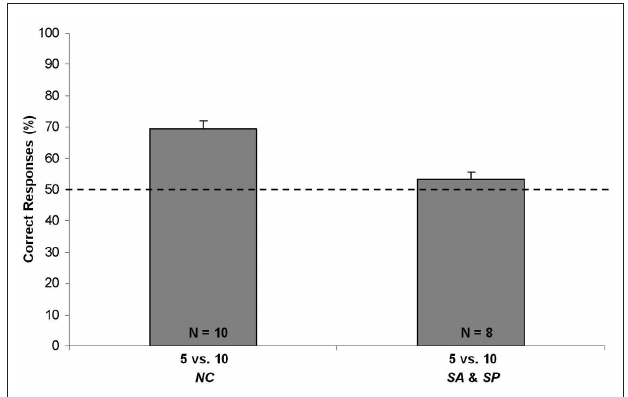
Figure 5 | results of exp. 3. Percentages of correct responses (group means ± SEM) shown by chicks of SA and SP conditions, that underwent the 5 vs. 10 test, following familiarization with element of various dimensions. The dotted line ( y = 50) represents